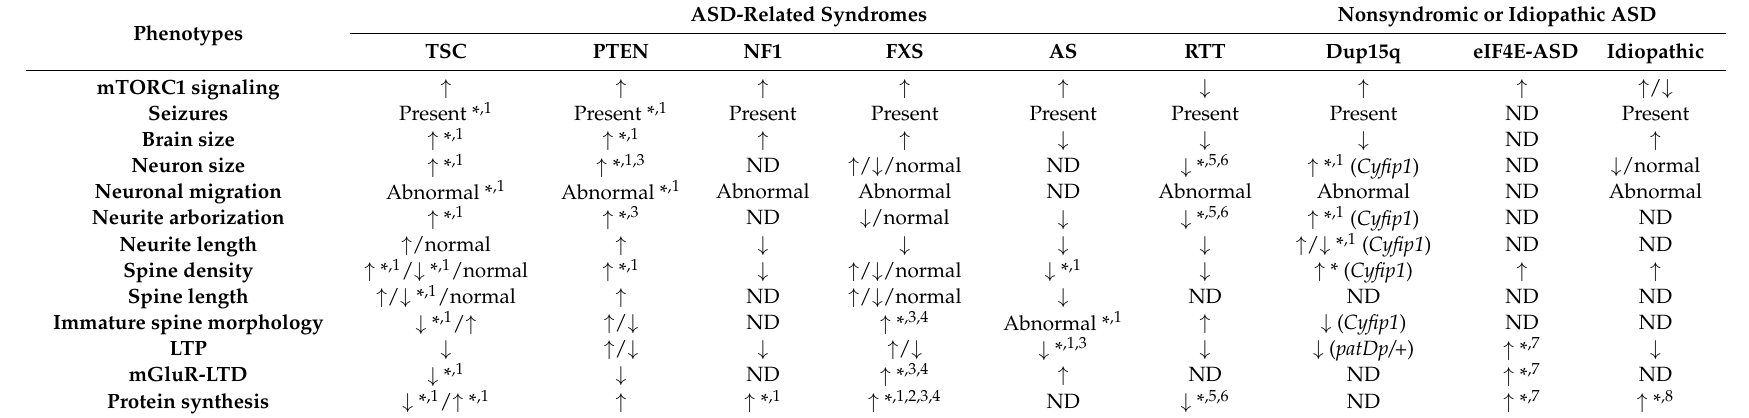
Table 1. Main brain functional and morphological features found in patients and/or in vitro human pluripotent stem cells models and/or rodent in vivo and in vitro models of autism spectrum disorder (ASD)-related syndromes and nonsyndromic ASD forms with evidence for aberrant mechanistic target of rapamycin complex 1 (mTORC1) signaling pathway (please see the manuscript text for complete details and references). The phenotypes that were rescued and/or prevented by targeting mTORC1 pathway at different levels are